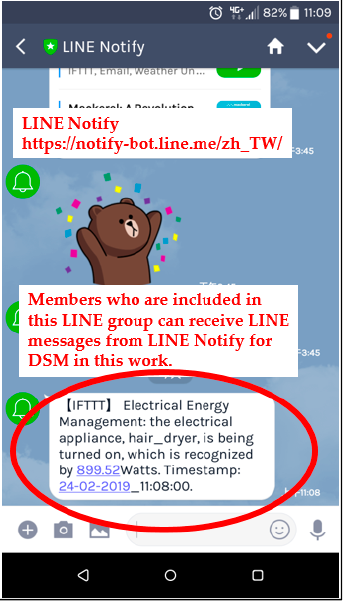
Figure 10. Received LINE Notify (https://notify-bot.line.me/zh_TW/) message based on the IFTTT (if this, then that) push notification service. The appliance event was pre-specified, identified, and then triggered for the monitored hair dryer.